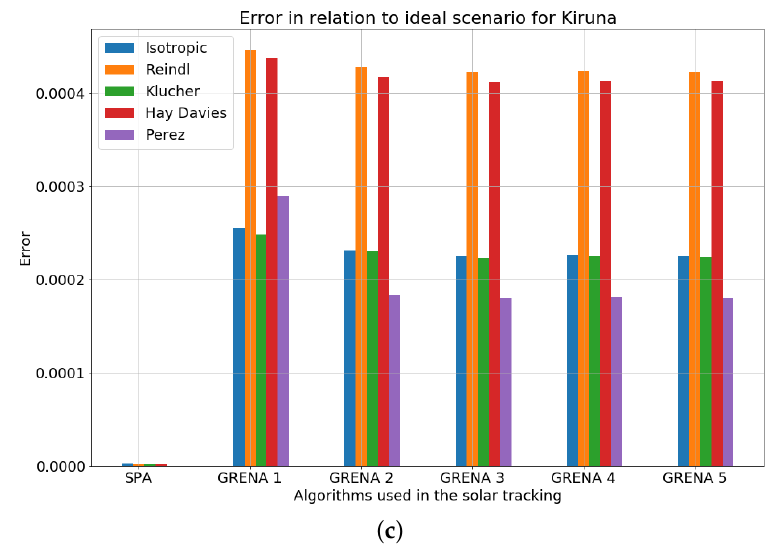
Figure 5. Error in relation to ideal scenario for: ( a ) Araçariguama, Brazil; ( b ) Cape Town, South Africa; ( c ) Kiruna, Sweden.